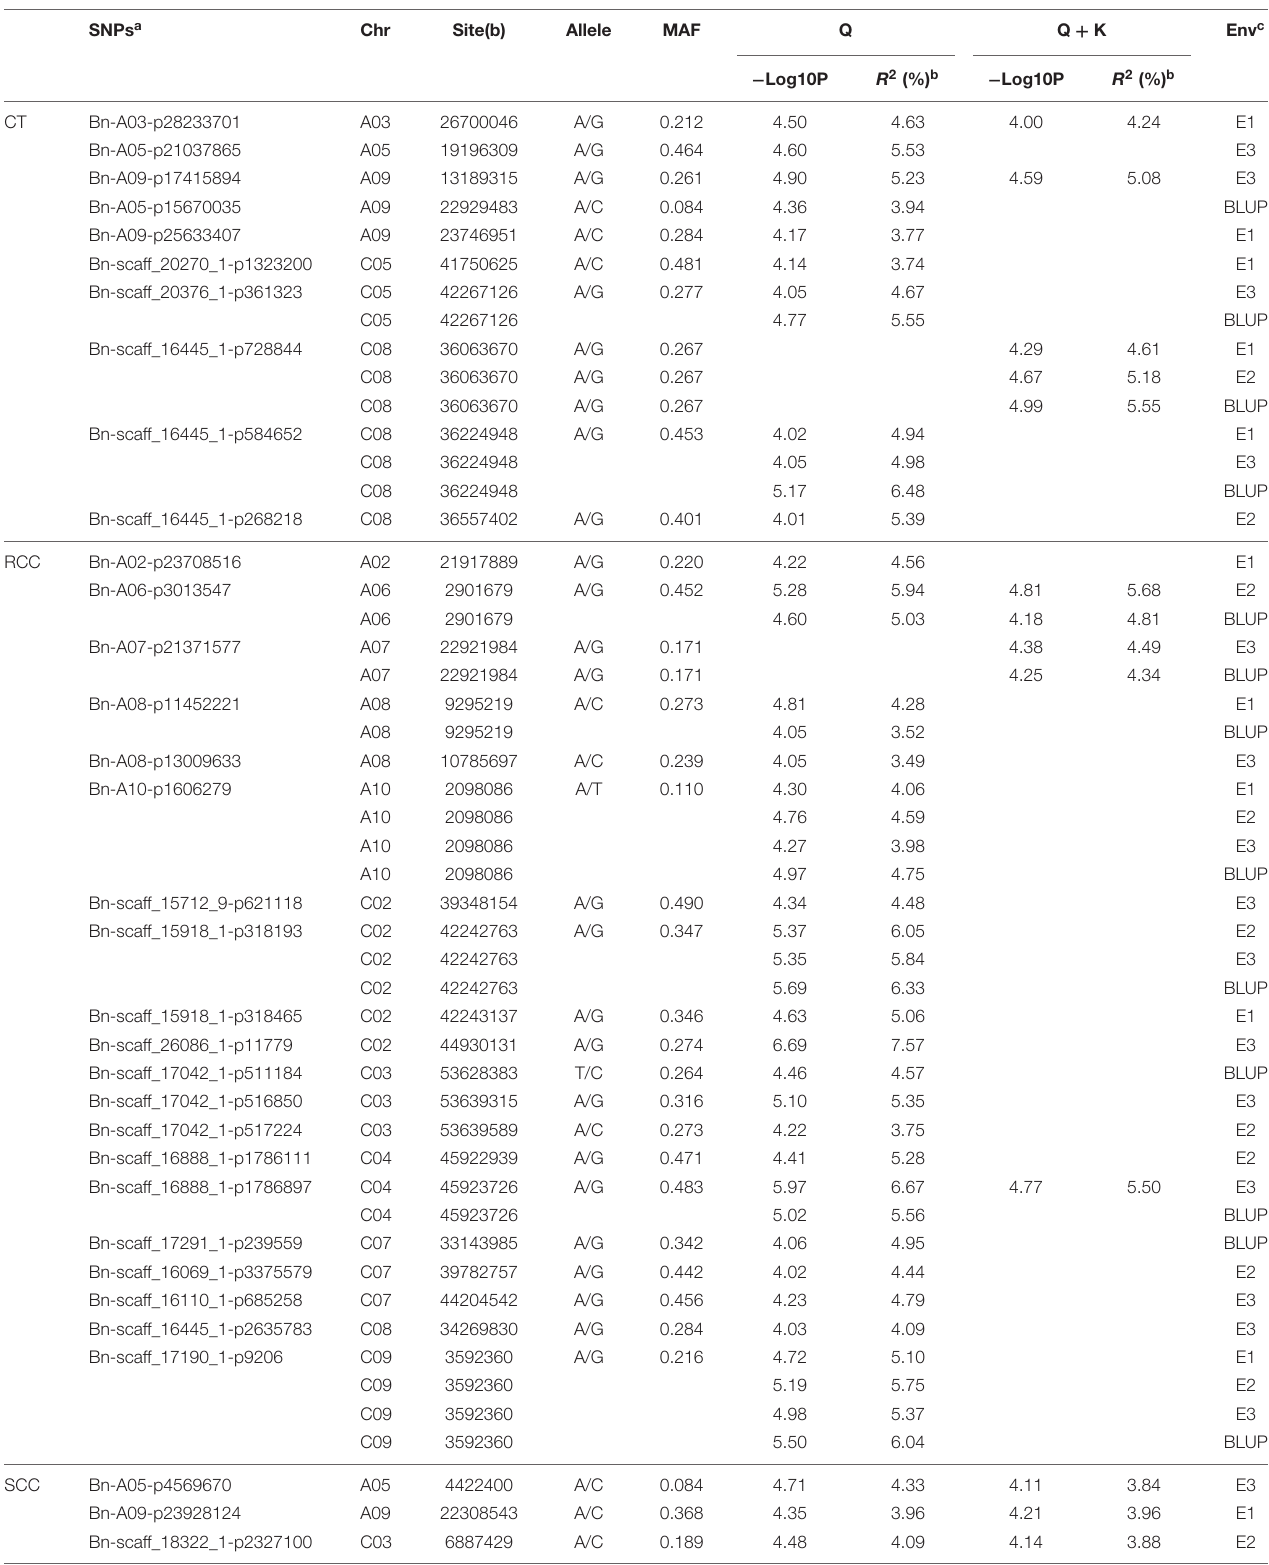
TABLE 3 | SNPs significantly associated with Cd accumulation and translocation in the three growth environments and BLUP. SNPs a Chr